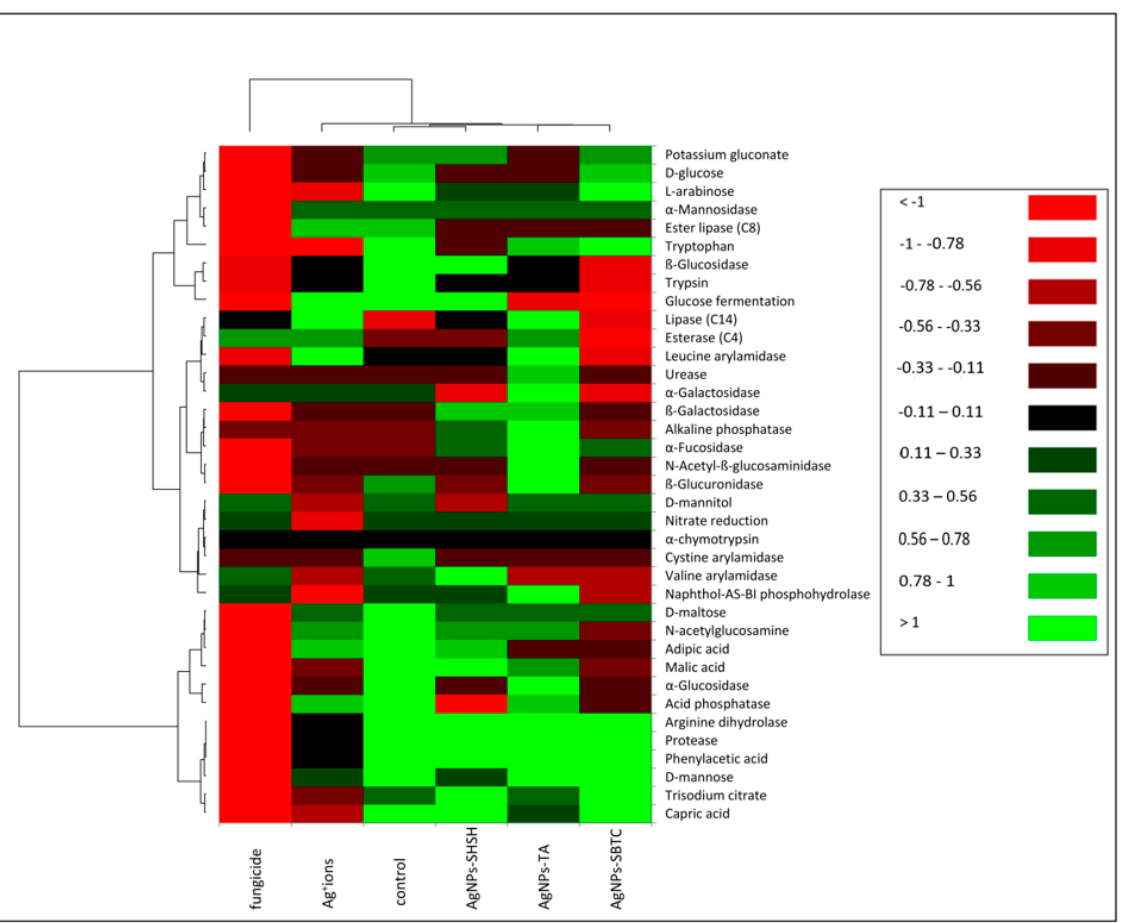
Figure 6. Heat map showing the potential of bacterial biochemical activity in the control and treated soils.